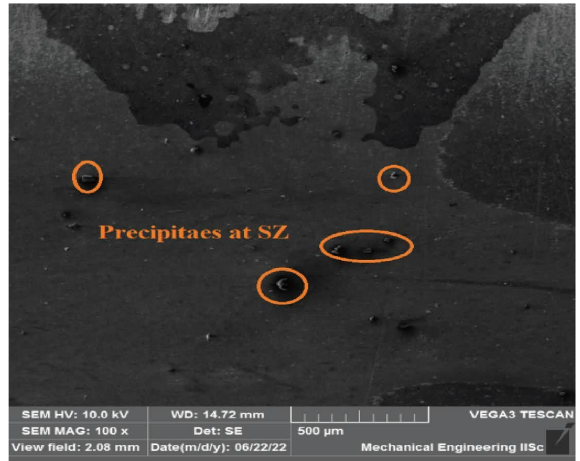
Figure 6: SEM micrograph of the weldment fabricated at 1100rpm.